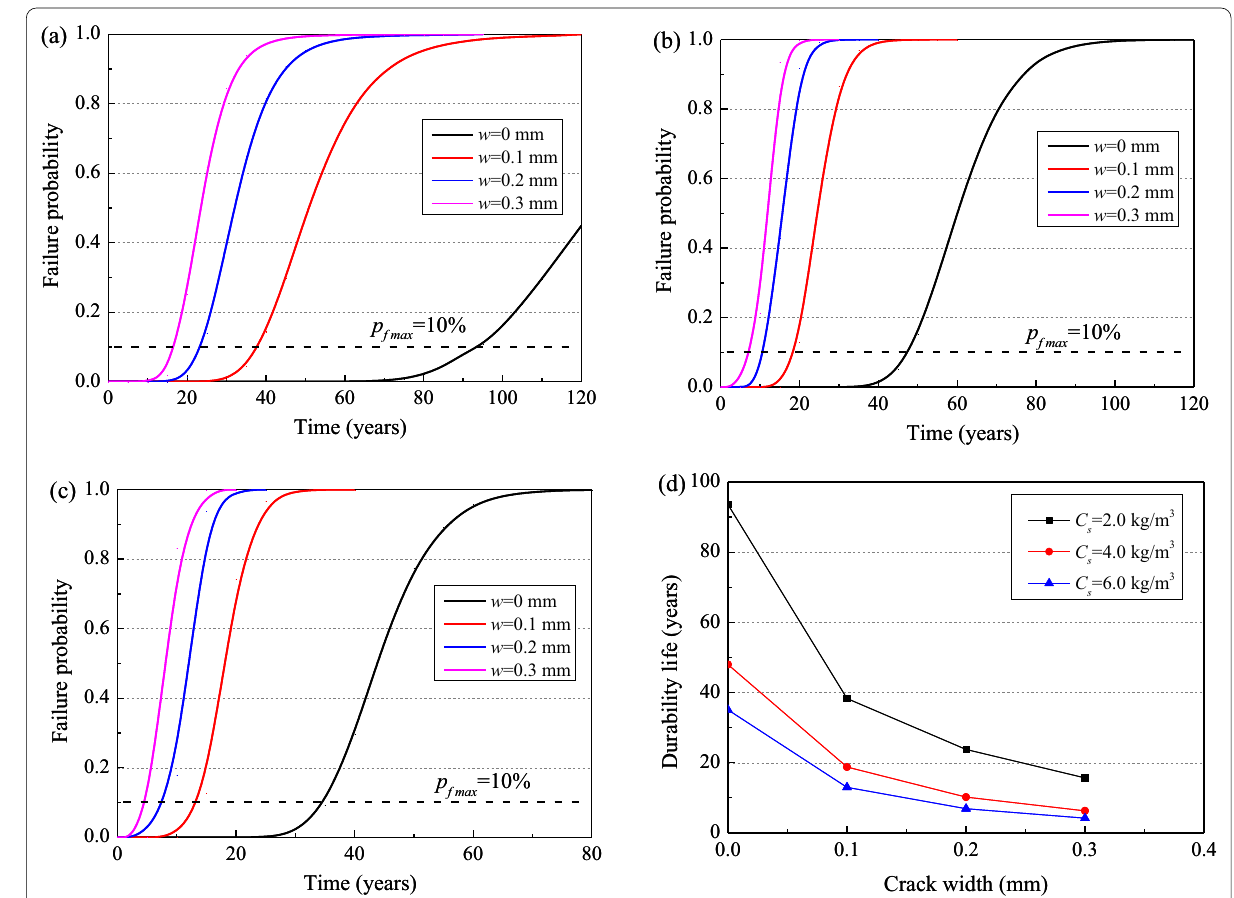
Fig. 8 Effect of surface chloride concentration on failure probability: a C s